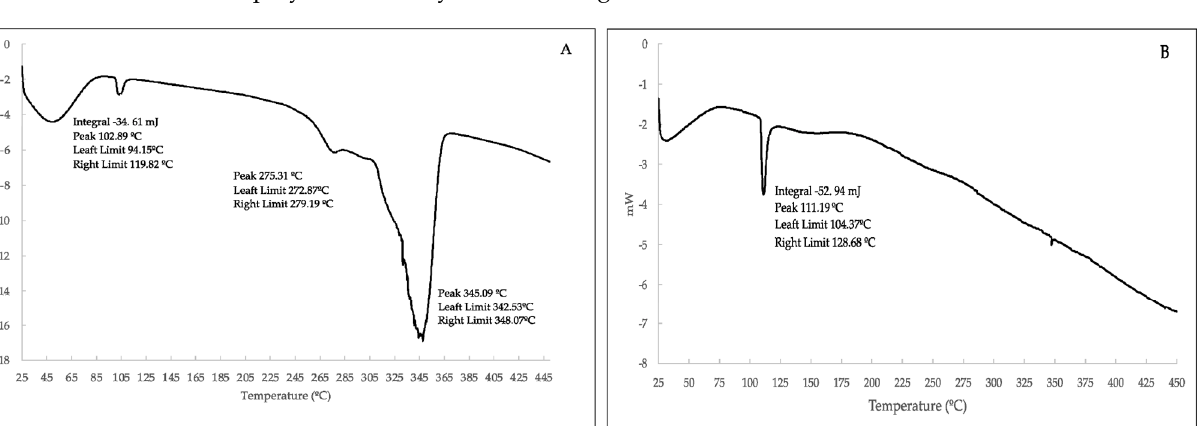
Figure 5. The differential scanning calorimetry (DSC) curves for the ( A ) β -cyclodextrin, ( B ) Fe 3 O 4 nanoparticles, ( C ) β -cyclodextrin-epichlorohydrin polymer, and ( D ) β -CD-EPI polymer-modified Fe 3 O 4 nanoparticles. The XRD pattern of the magnetic adsorbent is shown in Figure 6. Six characteristic diffraction peaks of Fe 3 O 4 can be found at 2 θ = 30.2°, 35.7°, 43.5°, 53.9°, 57.6°, and 63.2°. ( A )